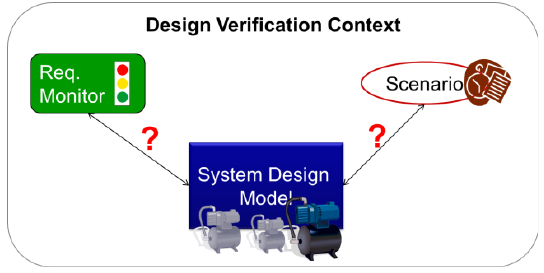
Figure 2: Integrating models for design